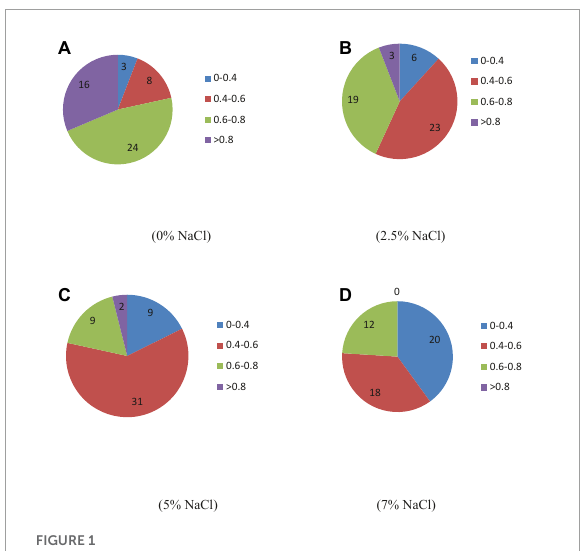
FIGURE1 Impact of different salinity levels on optical density (600 nm) of isolates. (A–D) Different levels of